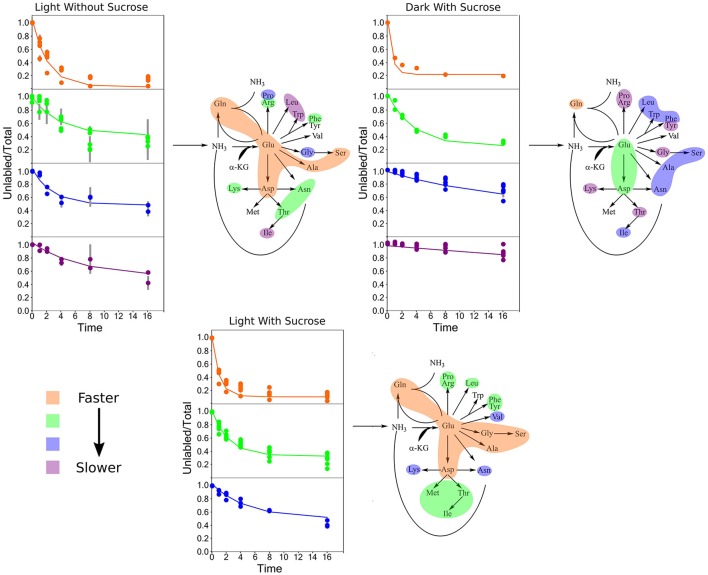
Average labeling patterns following the decay of the unlabeled isotopomer over time for each experiment. The lines are the models generated by R and the error bars represent ±1 SE. Maps adjacent to each set of graphs represent the flow of nitrogen among amino acids. The colored bubbles correspond to the clusters in the above figure highlighting similar isotopic exchange rates for the members of a cluster.